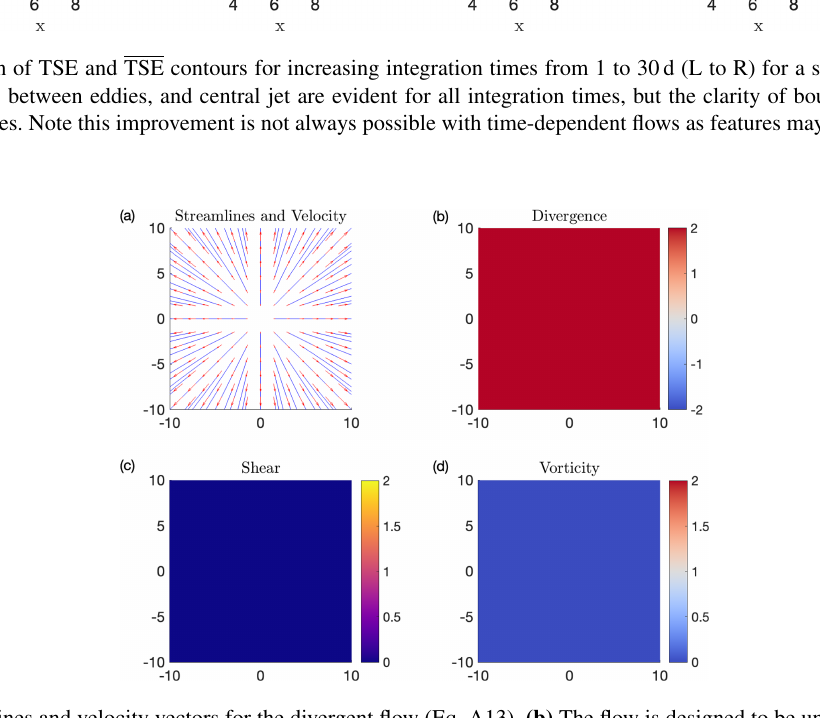
Figure A4. (a) Streamlines and velocity vectors for the divergent flow (Eq. A13). (b) The flow is designed to be uniformly divergent with a divergence value of 2. (c) Instantaneous values of zero shear. (d) Vorticity fields are also uniformly